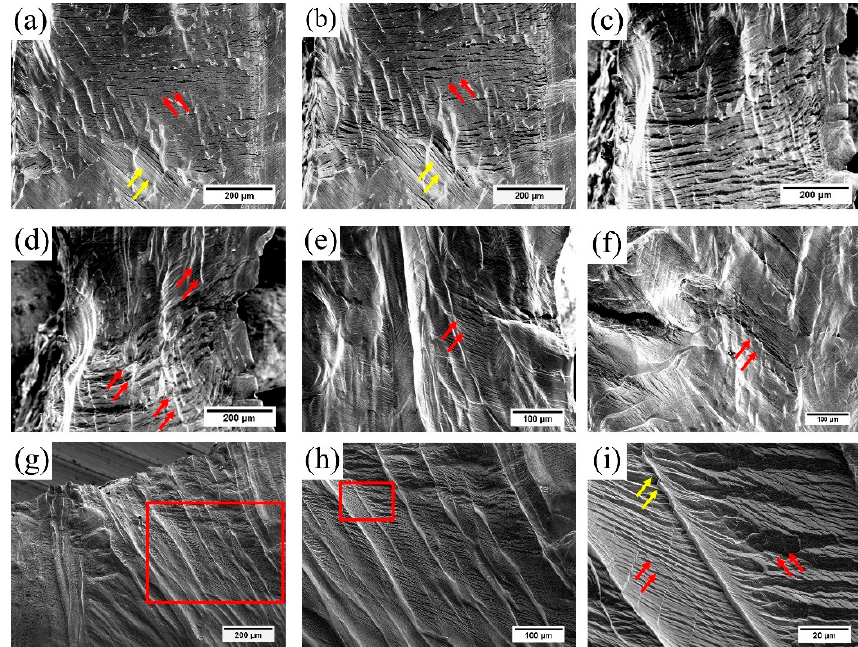
Figure 10. Fracture process in Z3CN20.09M CDSS during tensile tests. Figure ( a ) to ( f ) were from the samples under the “as received, 320 °C” condition with the same region; Figure ( e ) was from the sample under the “aged 2000 h, 320 °C” condition; Figure ( f ) was from the sample under the “annealed 3 h, 320 °C” condition. Figure ( a ) to ( f ) were all tested by Shimadzu SS550. Figure ( g ) to ( h ) were from the samples under the “as received, 320 °C” condition then imaged by SEM after tensile tests. Figure ( h ) is the magnified image of the rectangular region in Figure ( g ), and Figure ( i ) is the magnified image of the rectangular region in Figure ( h ). The tensile axis moves along the vertical direction in all the figures.